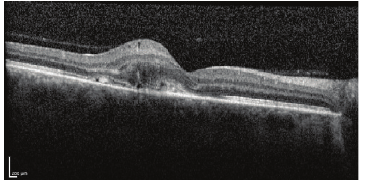
Figure 2: The baseline optical coherence tomography image of the same subject from Figure 1. Notice the presence of retinal fluid and choroidal neovascularization in the subretinal